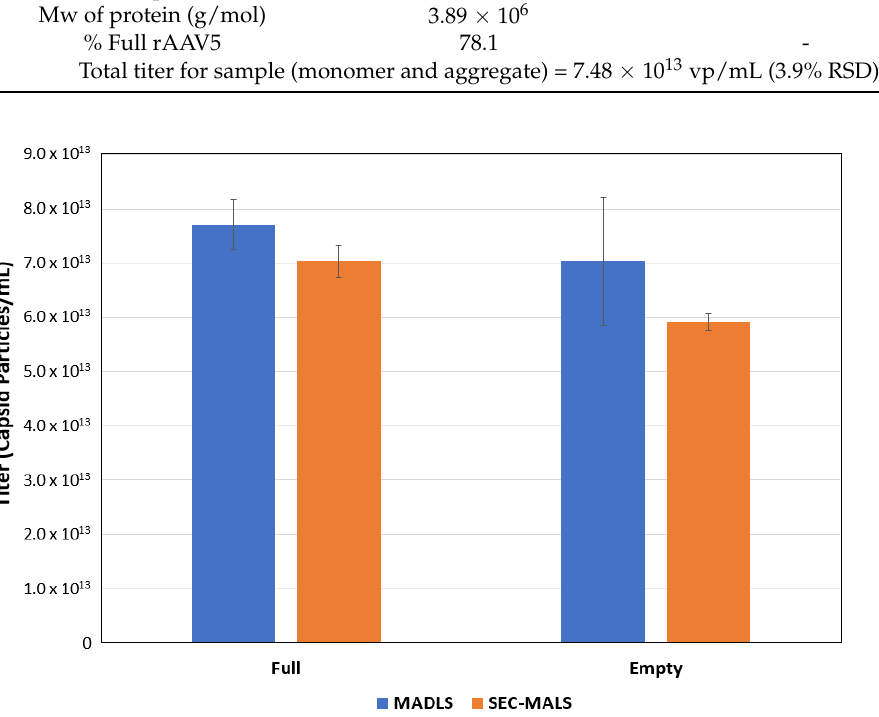
Table 3. Quantitative parameters for rAAV5 (Full).